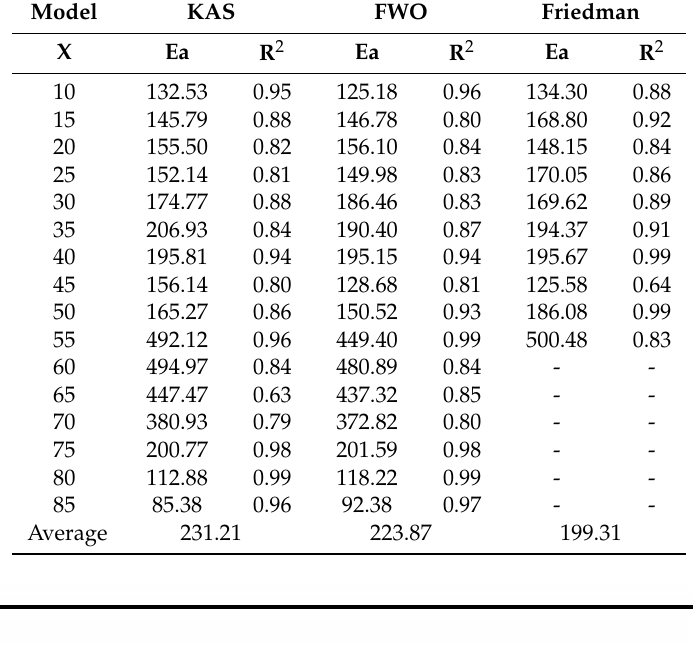
Table 7. Activation energies Ea (kJ/mol) and correlation coefficients R 2 calculated by KAS, FWO and Friedman models.